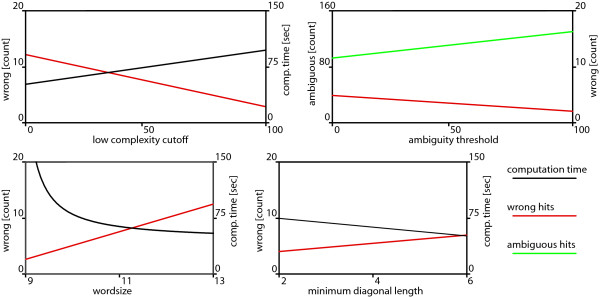
Effect of the most important parameters on the performance of PanGEA-BlastN. Values were calculated for mapping of 1000 randomly generated 250 bp fragments from D. melanogaster transcripts to the corresponding genes. Benchmarks were calculated in triplicate for five (or more) datapoints [see Additional file 5]. If not stated otherwise the following parameters were used: word length 11; minimum diagonal 3; low complexity threshold 20; ambiguity 12.